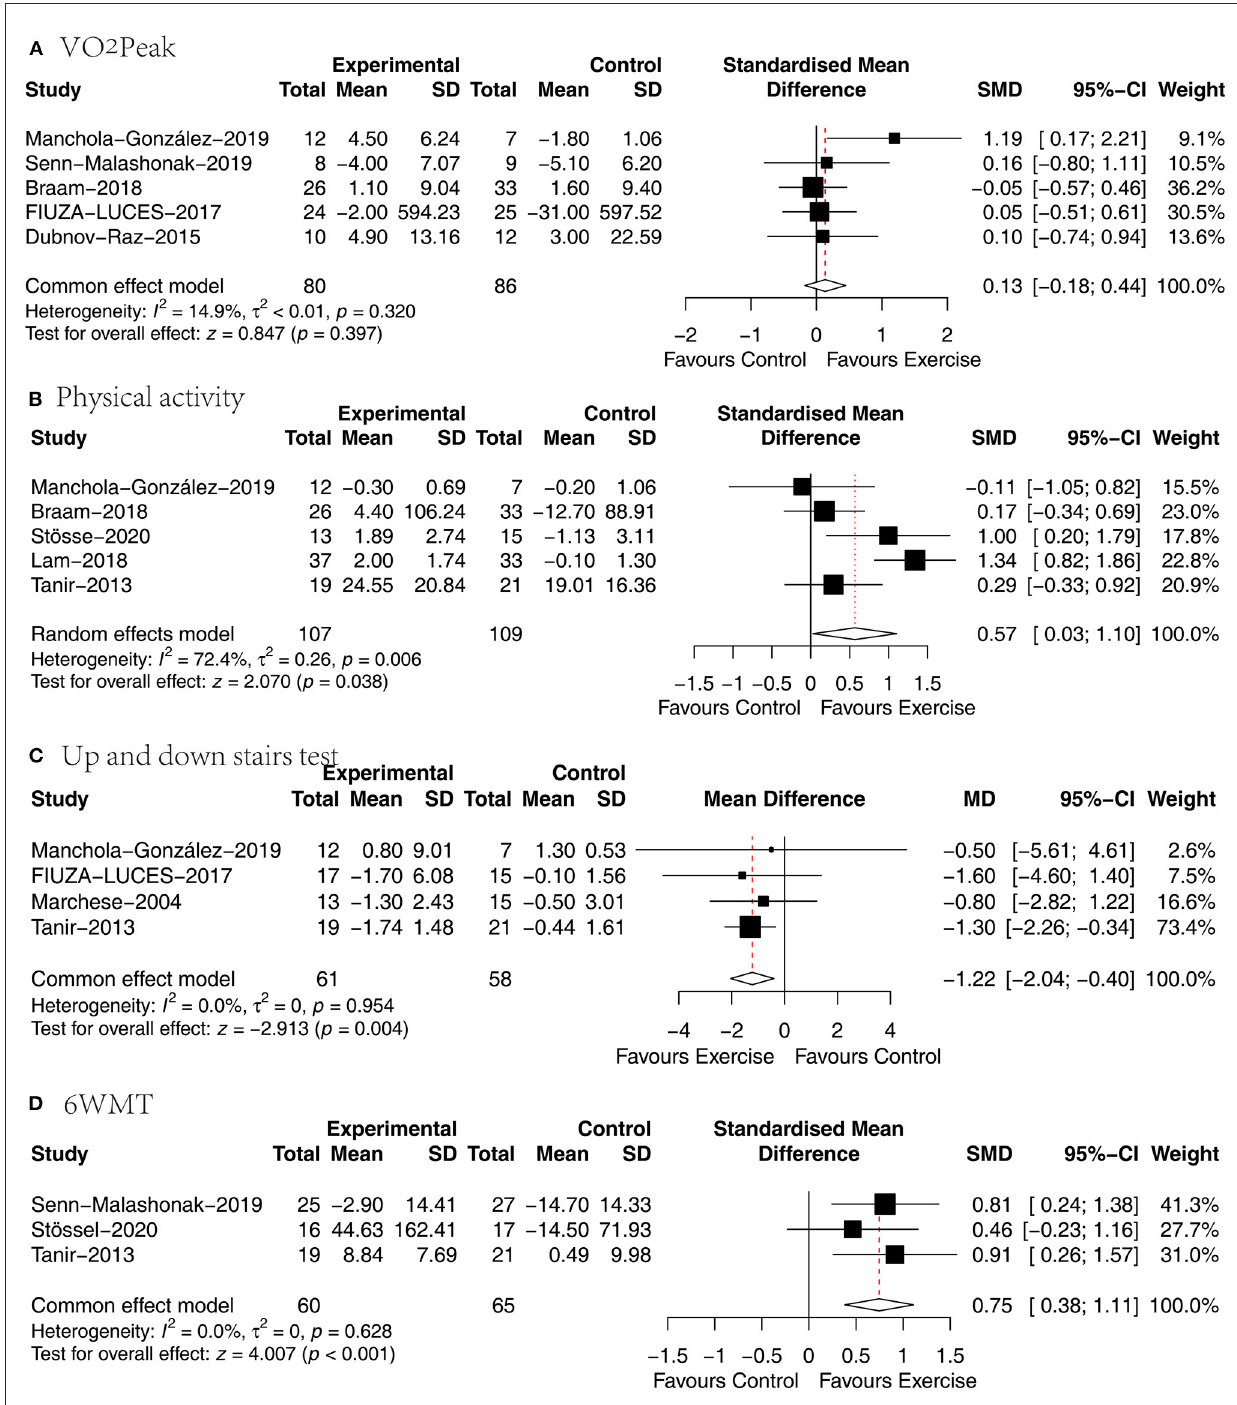
FIGURE4 Results of meta-analysis of (A) VO 2 Peak, (B) physical activity, (C) up and down stairs test, (D) 6WMT.